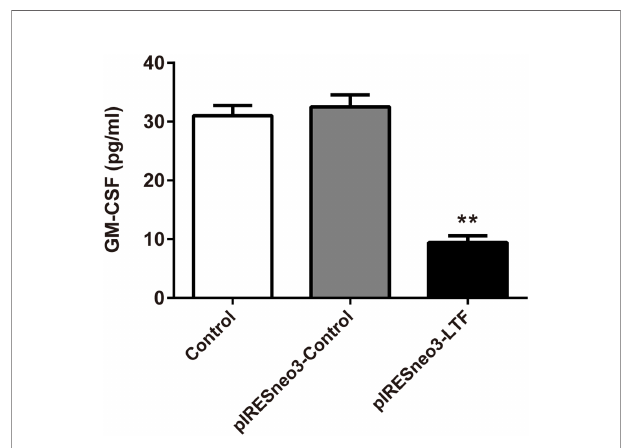
FIGURE 8 | LTF overexpression downregulated GM-CSF level in PC-3. The culture supernatant was subjected to ELISA. The results were presented as mean ± SD (n = 3). **P < 0.01 vs .